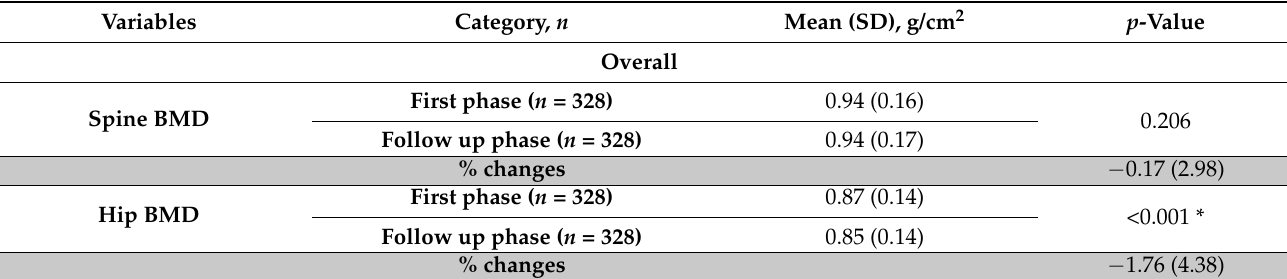
Table 4. Changes in hip and spine BMD after the